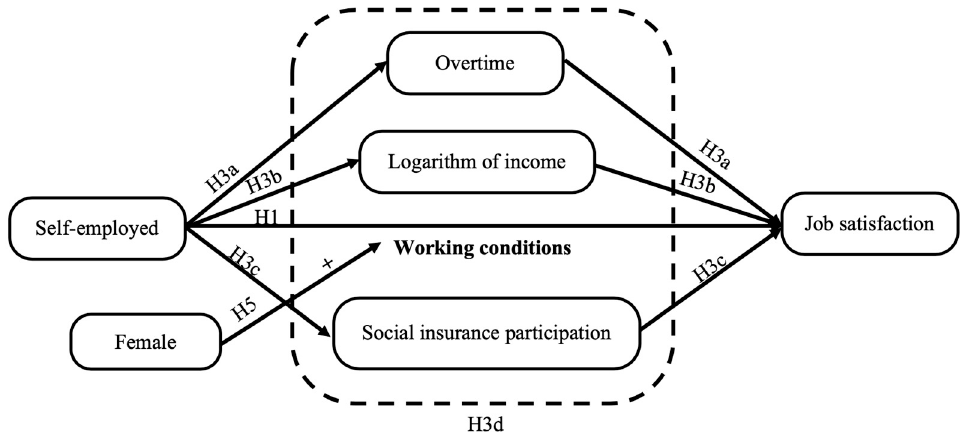
Figure 1. Model of the impact mechanism of self-employment on job satisfaction.